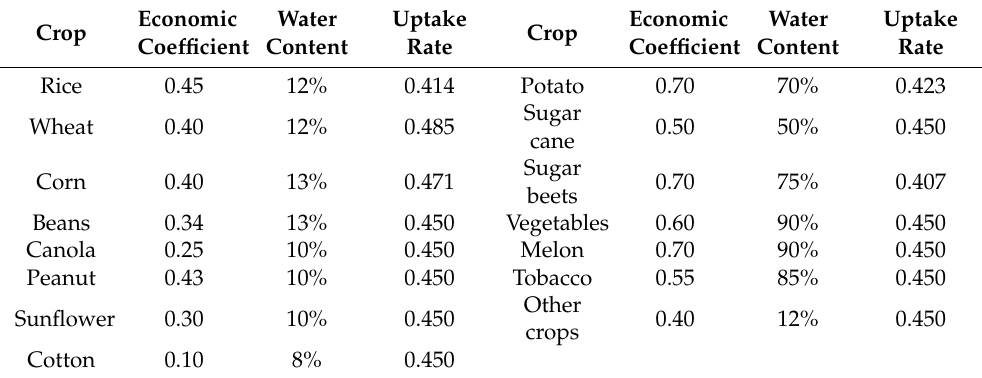
Table 1. Basis for determining carbon uptake in